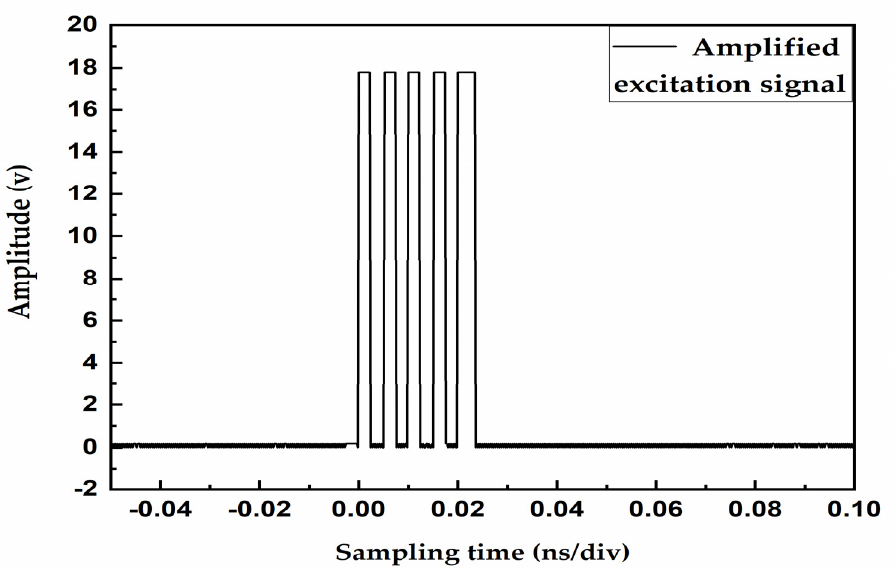
Figure 4. Amplified excitation signal by the amplifier circuit.